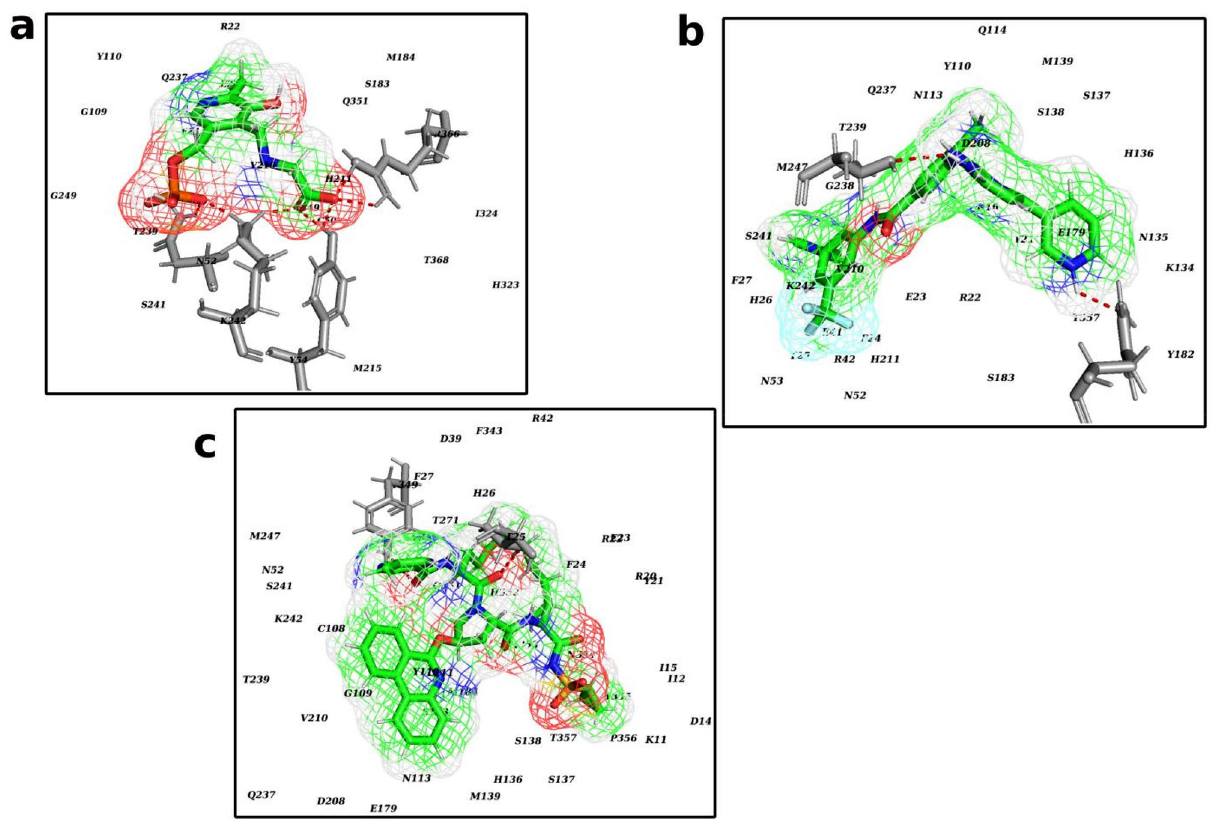
Figure 8. Characterization of the active site residues at the binding site ( a ) PLP-Gly ( b ) Nilotinib ( c )